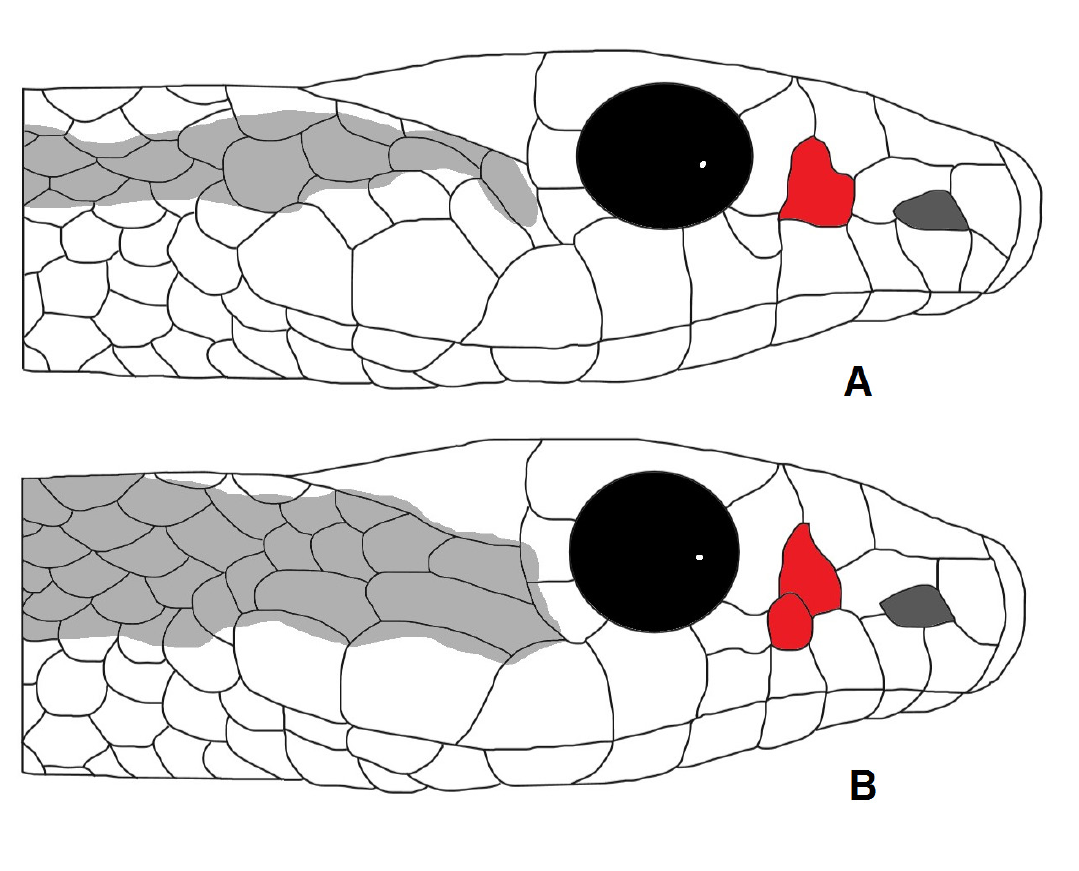
Fig. 18. A . Loreal scale single. B . Loreal